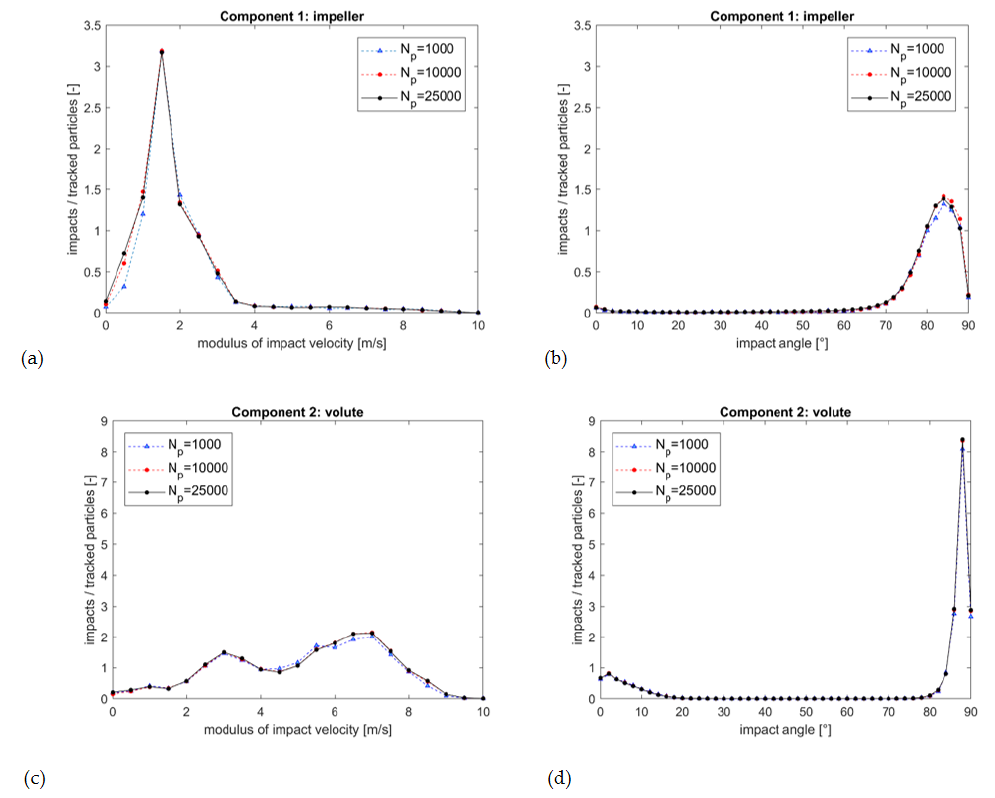
Figure 2. Frequency distribution of particle impact velocity and impact angle for the impeller ( a , b ) and the volute ( c , d